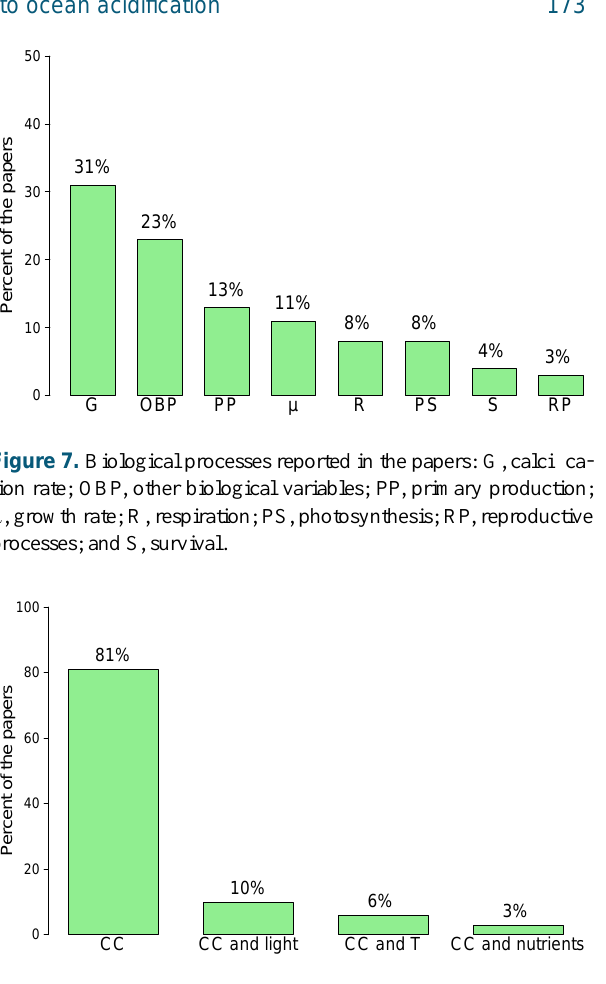
Figure 8. Percent of the papers that have manipulated the carbon- ate chemistry alone and those that have manipulated the carbonate chemistry as well as another variable. CC, carbonate chemistry; T,